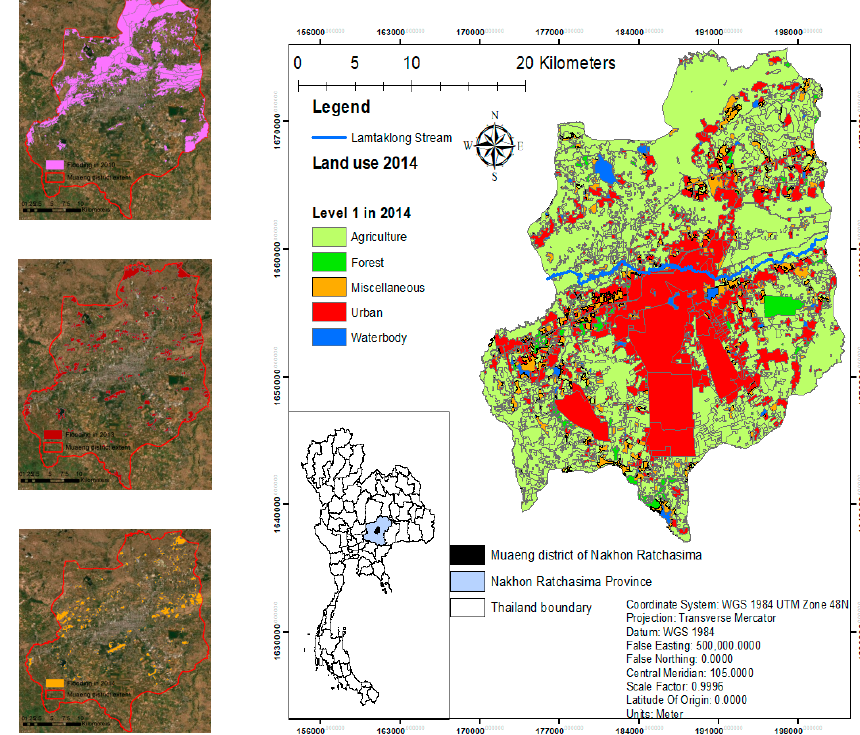
Figure 1. Significant floods in 2010, 2013, and 2014 covered in land-use / land cover (LU / LC) of Mueang district extent, Nakhon Ratchasima province derived using visual interpretation in December 2014.